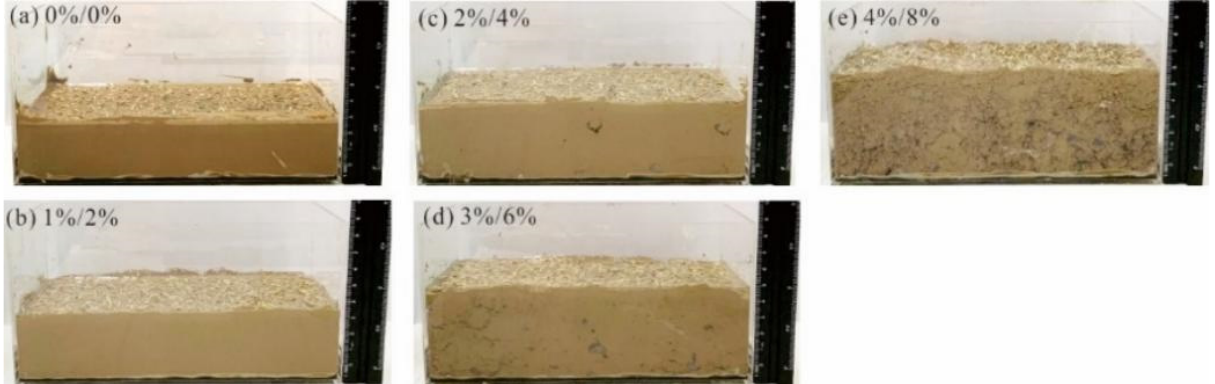
Figure 10. Initial state of the composite sample: ( a ) PVA content: 0%, attapulgite: 0%; ( b ) PVA con- tent: 1%, attapulgite: 2%; ( c ) PVA content: 2%, attapulgite: 4%; ( d ) PVA content: 3%, attapulgite: 6%; ( e ) PVA content: 4%, attapulgite: 8%.